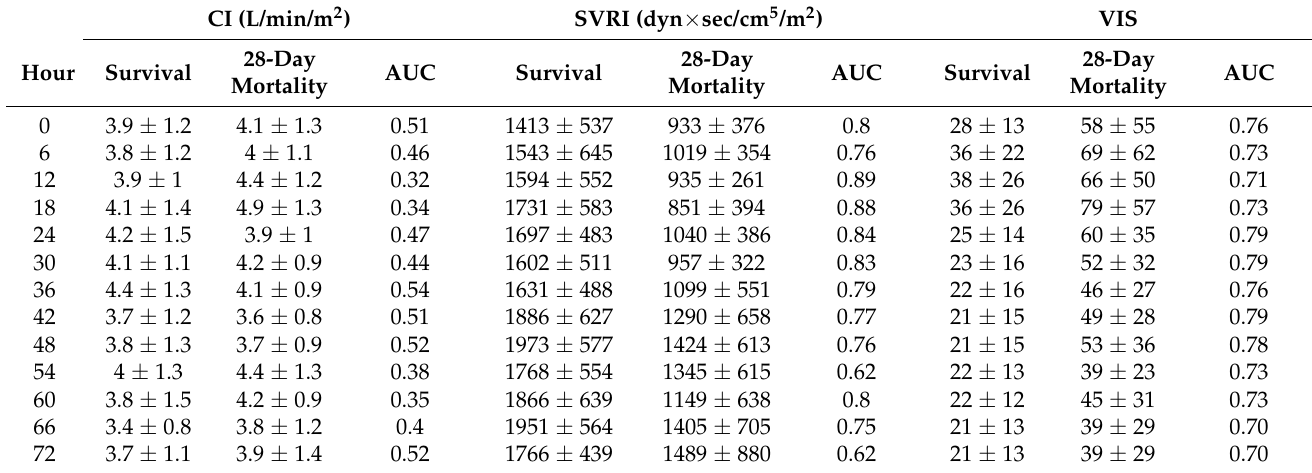
Table 3. Comparison of CI, SVRI, VIS, and ROC at six-hour intervals between survivors and non- survivors.